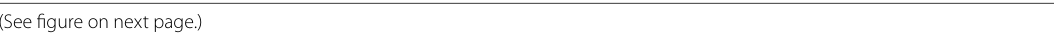
Fig. 3 a – d View onto the interstitial situation at the a mature, b extending, c extended renal vesicles (RV), and the d early comma-shaped body (CSB) in the fetal human kidney during advanced pregnancy by the optical microscope. a While the mature RV arises, at its distal pole, a transverse but only partial separation (dashed black line) from the overlying pretubular aggregate (PTA) occurs. This is visible at the end of the clear interface (black asterisks) and the beginning of the adhesion (white asterisk) next to the section border between the head (H) and conus (CO) of the CD ampulla (A). The lateral part of the distal pole at the RV remains connected with the proximal end of the PTA via a two-layered progenitor cell strand (arrow head). b In the extending RV, the interjacent cleft transversely expands. The distal pole of the RV stays near the proximal end of the PTA so that a cone is formed by the subcapsular interstitium (yellow line with crosses) and the perivascular interstitium (white boxes with red line) of a perforating radiate artery (PRA). The future connecting tubule (CNT) starts to invade the CD ampulla, while the tubule anlage (TA) elongates. c Due to the vertical elongation of the CD ampulla and the internal folding in the extended RV, the interstitial cleft (white arrow) between the CNT and the progenitor cell strand turns direction from transverse to vertical, increases in length, and forms a pocket. In parallel, the narrow vertical interstitial cleft between the conus of the CD ampulla and the medial aspect of the renal vesicle expands in vertical direction. It originates from the cone, which is formed by the peritubular interstitium of a previously developed CNT (black line) and the perivascular interstitium of the perforating radiate artery. d While the early comma-shaped body is forming, the progenitor cell strand, which earlier connected the distal pole of the extended renal vesicle with the proximal end of the PTA, dissolves. This causes that the interstitial pocket yet fuses with the perivascular interstitium next to the PTA. As a consequence, between the tubule anlage and the developing lateral fold, a vertical cleft (white boxes with red line and arrow head) arises. This is a morphological sign that the glomerulus defoliates at the proximal